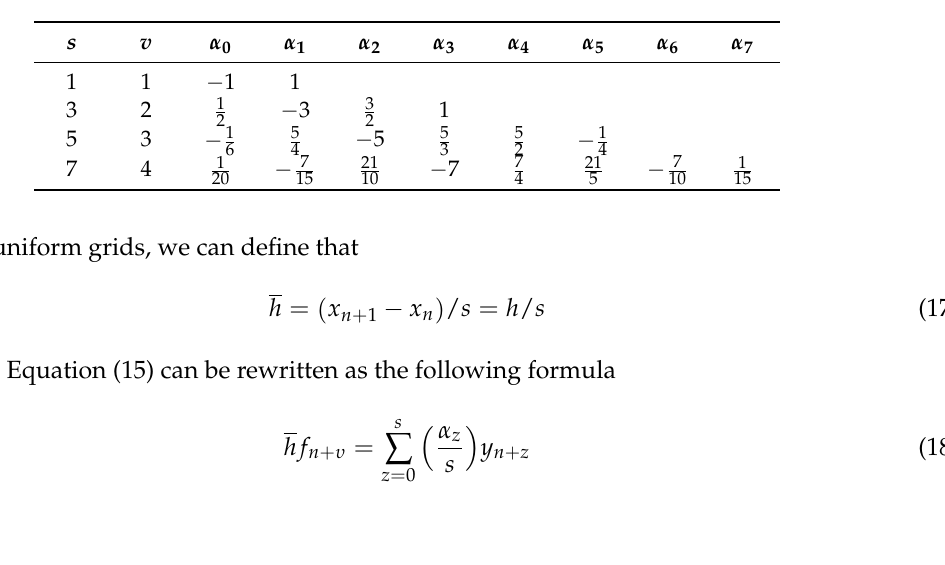
Table 2. The coefficients of GBDF using uniform grids (for odd s